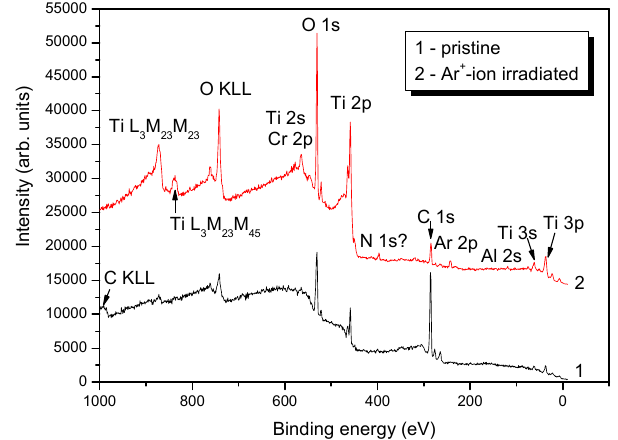
Figure 6. Panoramic XPS spectra of the investigated specimen before (1) and after (2) cleaning its surface with Ar + ions.